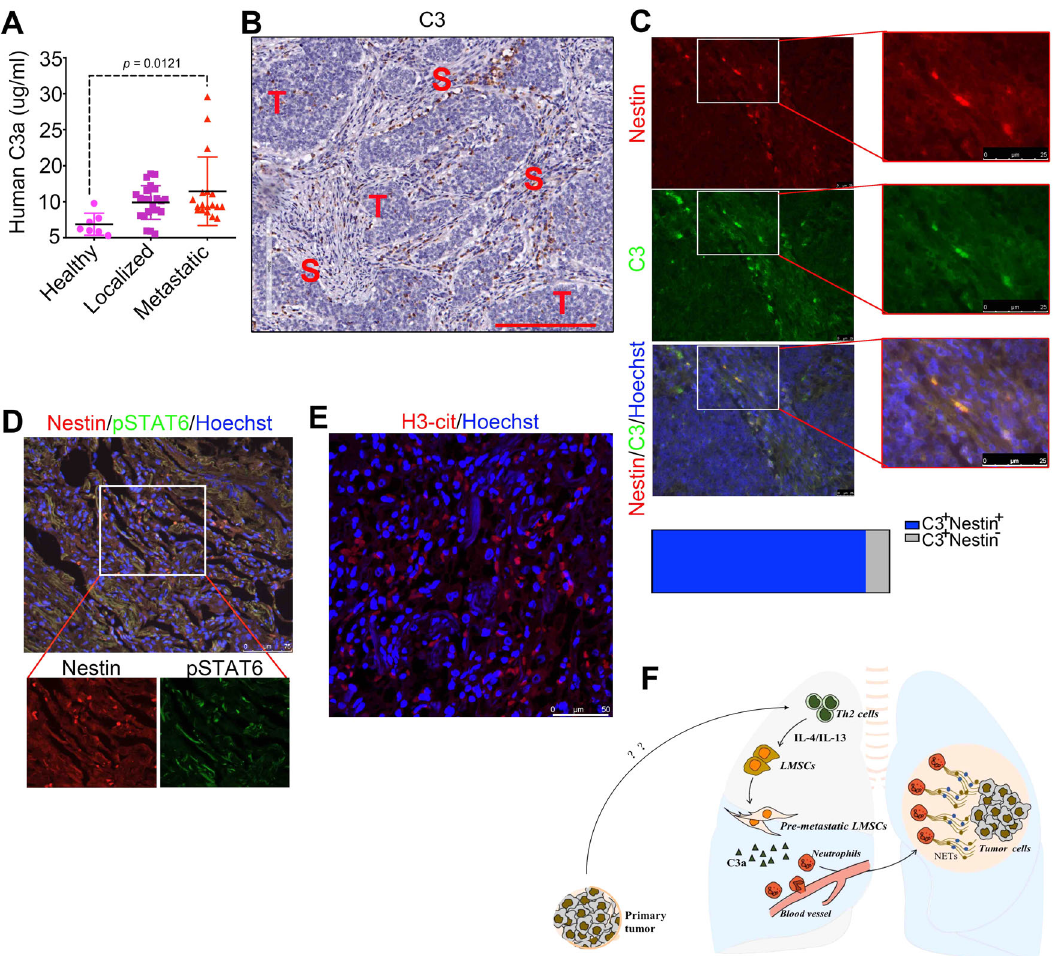
Fig. 7 High C3 expression levels are associated with metastasis in breast cancer patients. A ELISA quanti fi cation of C3 in serum samples obtained from breast cancer patients with solid primary tumors or metastatic tumors. Final clinical diagnosis is indicated. n = 18 patients with metastasis, 23 patients with no metastasis, 7 healthy individuals. Data are presented as mean values± SD, using a one-way ANOVA with Sidak ’ s post test. Source data are provided as a Source Data fi le. B Representative immunohistochemistry image showing the strong C3 (brown) staining in the stroma of breast cancer metastasized to the lung. Scale bar represents 200 μ m. The images were representative of nine breast cancer patients with lung metastasis. C Representative immuno fl uorescence images showing the colocalization of Nestin (red) and C3 (green) in pulmonary tissues, in a patient with lung metastasis. Scale bar represents 25 μ m. The percentages of C3 + Nestin + cells and C3 + Nestin − cells were shown in the horizontal bar. The images were representative of nine breast cancer patients with lung metastasis. D pSTAT6 (red) and Nestin (green) staining of pulmonary tissues from metastatic breast cancer site (MBC). Pulmonary tissue sections were examined for pSTAT6 and Nestin by IF. Scale bar represents 75 μ m. The images were representative of nine breast cancer patients with lung metastasis. E H3-cit (red) staining of pulmonary tissues from metastatic breast cancer site (MBC). Pulmonary tissue sections were analyzed for H3-cit by immuno fl uorescence. Scale bar represents 50 μ m. The images were representative of nine breast cancer patients with lung metastasis. F A schematic model depicting the mechanism by which LMSCs promote metastasis. The Th2 cytokines IL-4 and IL-13 induce LMSCs to express C3, which recruit neutrophils to the lung and induce NET formation. NETs retain the tumor cells and allow the newly arrived tumor cells to